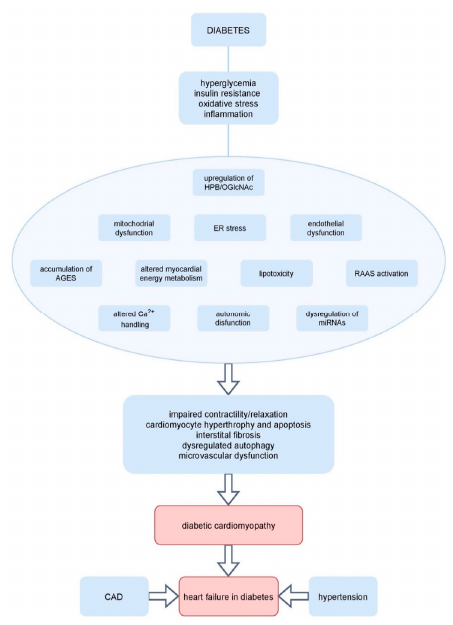
Figure 1. Potential mechanisms involved in diabetic cardiomyopathy. AGE, advanced glycation end products; CAD, coronary artery disease; HBP, hexosamine biosynthesis pathway; miRNA, microRNA; O-GlcNAc, O-linked beta-N-acetylglucosamine; RAAS, renin–angiotensin–aldosterone system; ER endoplasmic reticulum.